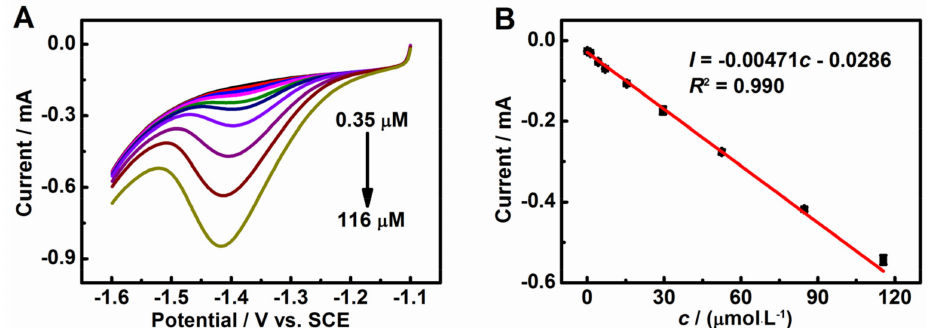
Figure 6. ( A ) LSV profiles at 3DGrls/PGE in pH 9.18 PBS containing different concentrations of HMF from 0.35 to 116 µ M. ( B ) The relationship between the reduction peak current and HMF concentration. Scan rate: 100 mV s − 1